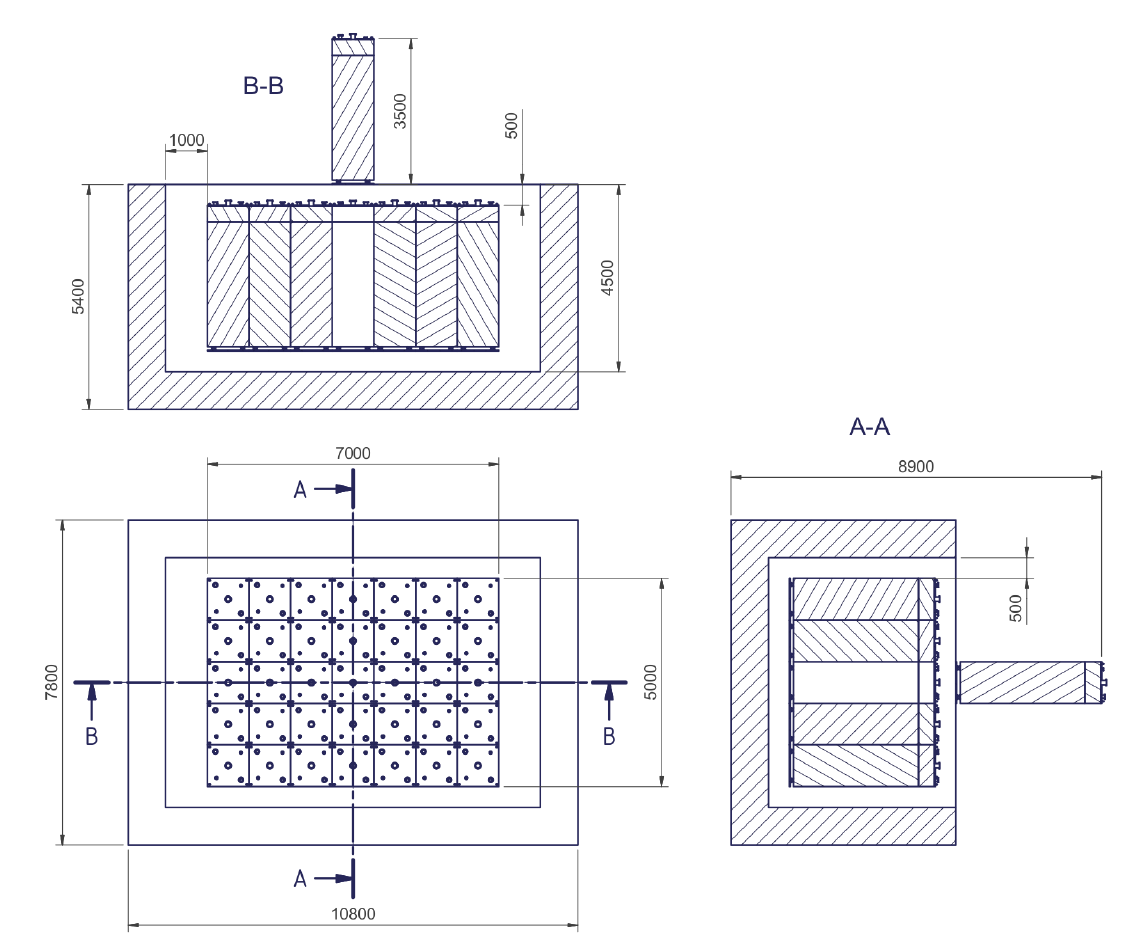
Figure 5. The current dimensions for the ArgonCube detectors in ND-LAr. The cryostat is based on the 35ton prototype and ProtoDUNE [62], and is yet to be optimized for the DUNE ND. In this figure, the lower left is the top view, the upper plot is a view of a horizontal cut transverse to the beam, and on the lower right is a horizontal cut along the